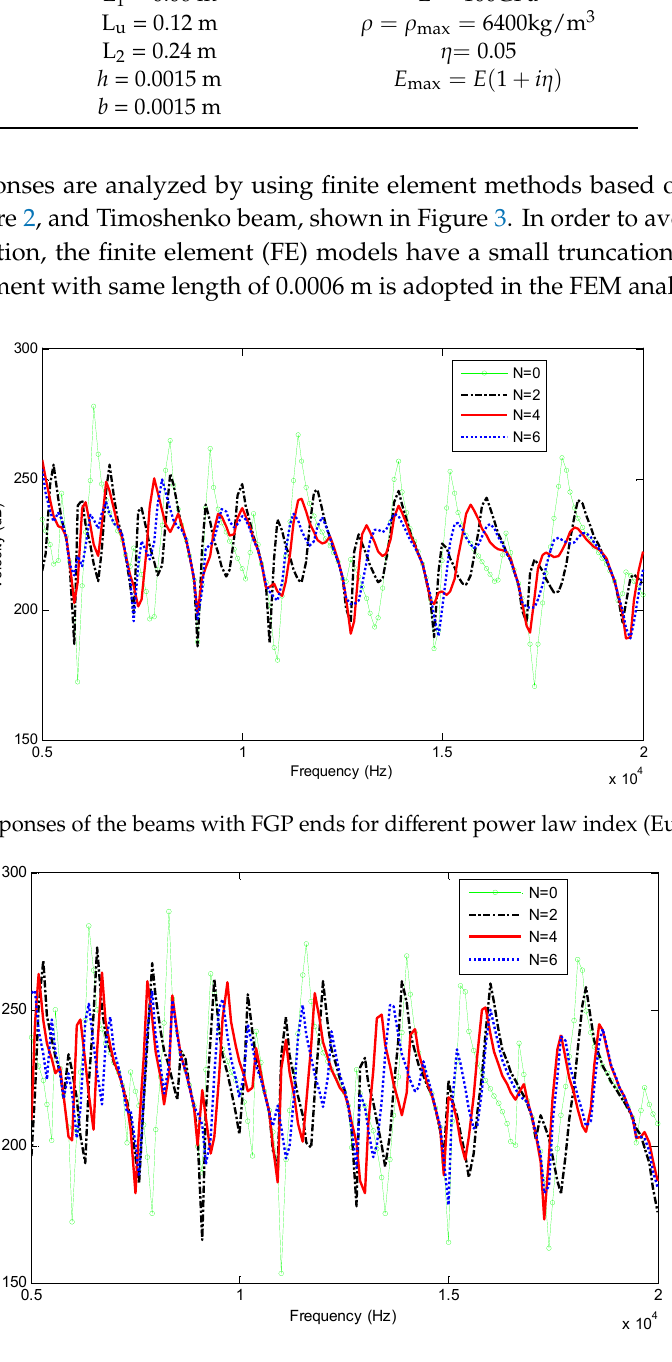
Figure 3. Frequency responses of the beams with FGP ends for di ff erent power law index (Timoshenko beam).